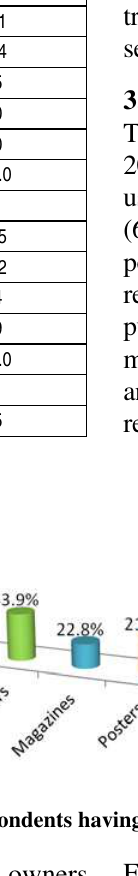
Table 2. Descriptive statistics for the question on the frequency of use